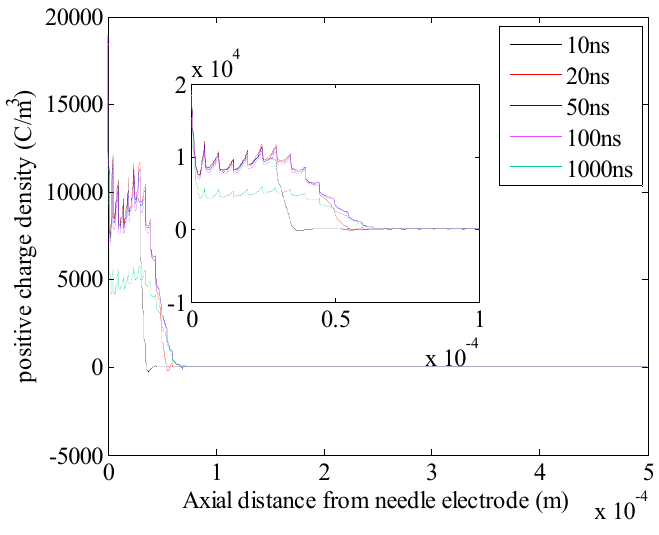
Figure 8. Positive charge distribution along the needle-sphere axis as a response to 1.2 PDIV with 10 mm needle-sphere electrode